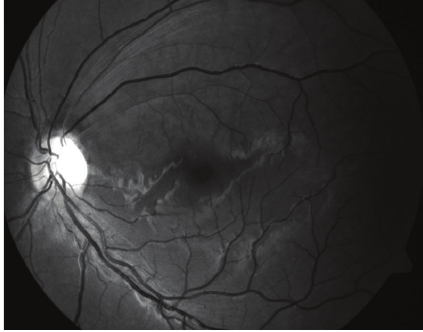
Figure 5: Red free image disclosing retinal nerve fiber loss in the affected area 6 months